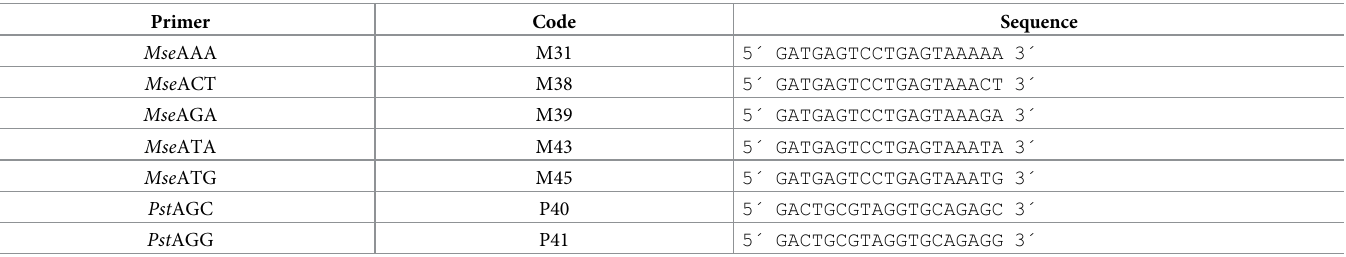
Table 2. AFLP oligonucleotide sequences used to analyze a durum wheat collection.